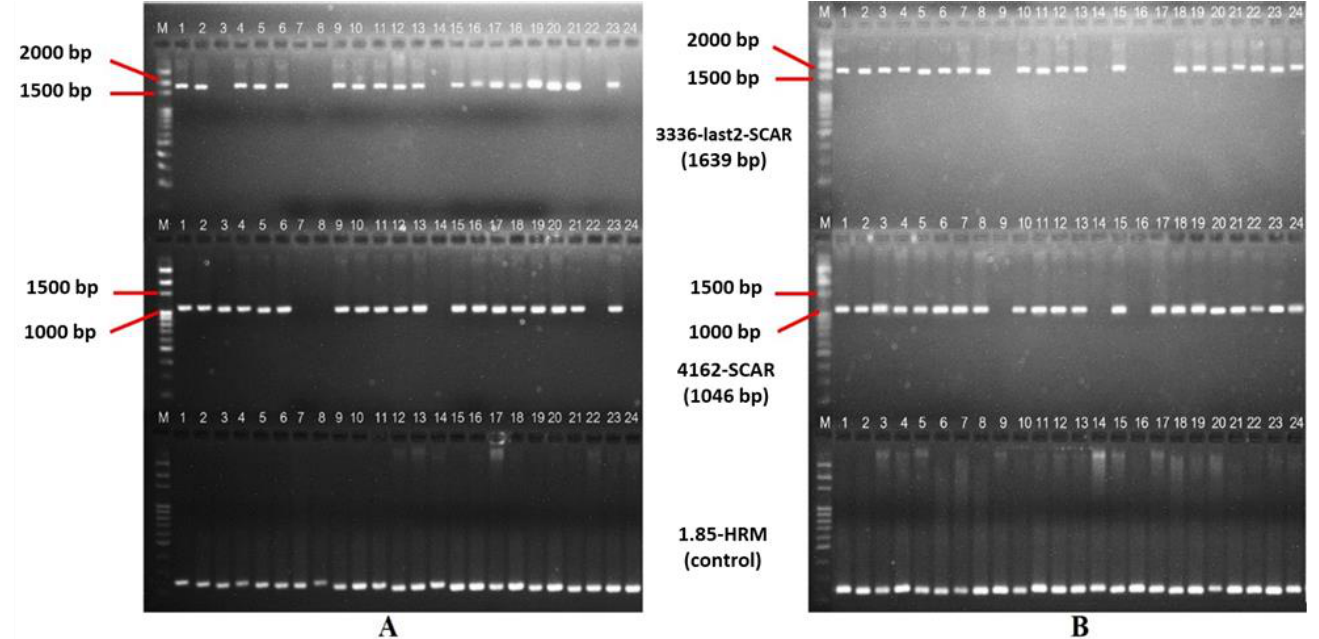
Figure 3. Amplification of 3336-last2-SCAR (top), 4162-SCAR (center), and 1.85 HRM (control) (bottom) in BC 2 F 2 progeny of the A-line group for 24 plants (lanes 1–24), BC 2 F 2 A1 × C1 ( A ), BC 2 F 2 A1 × C3 ( B ), and 100 bp DNA ladder (lane M).